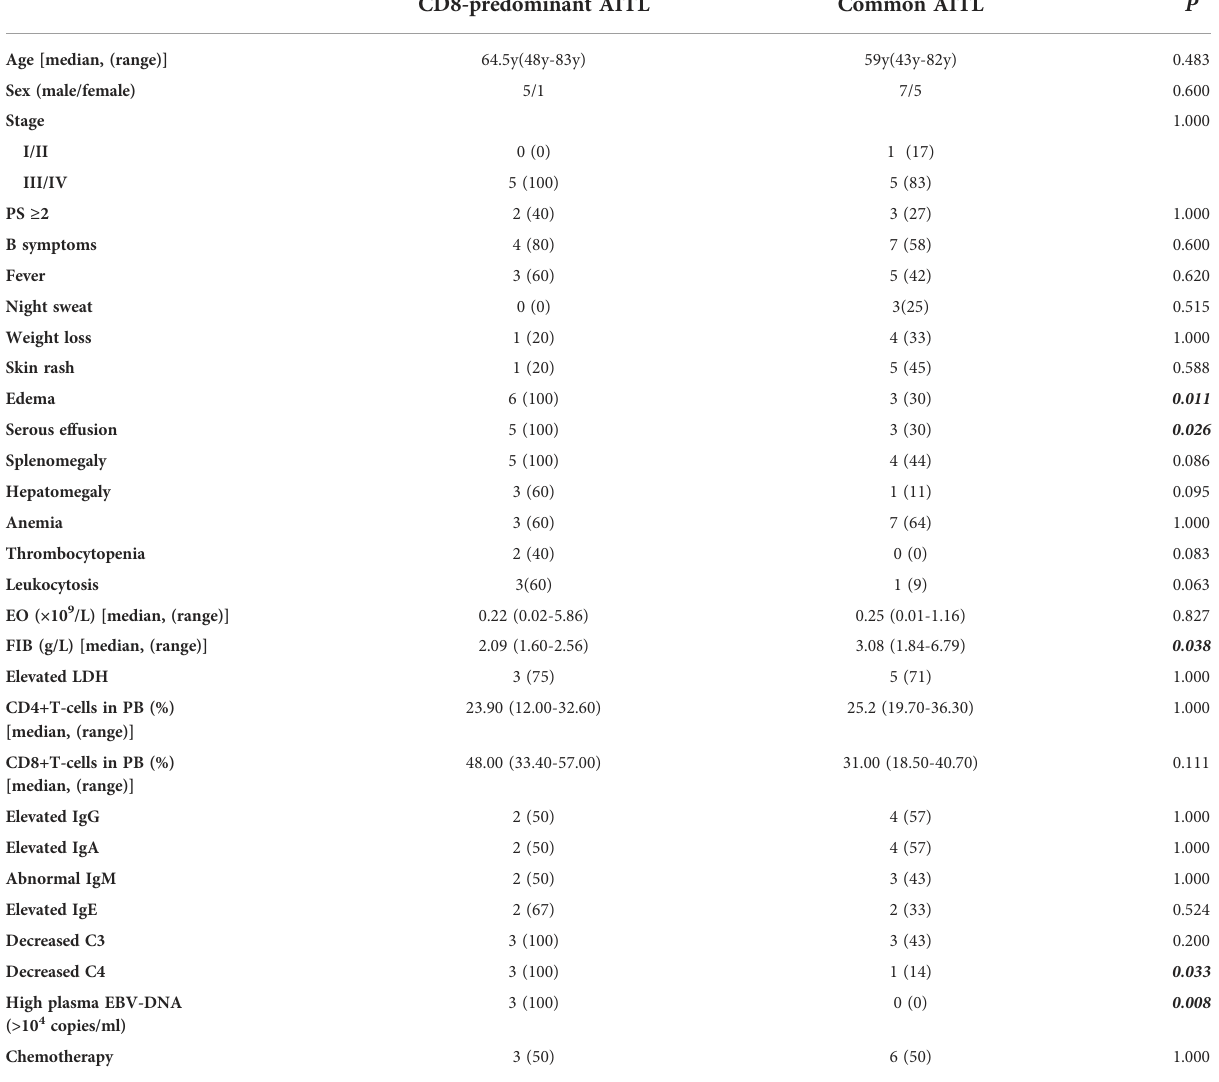
TABLE 1 Clinical comparison between microenvironment CD8-predominant AITLs and matched normal